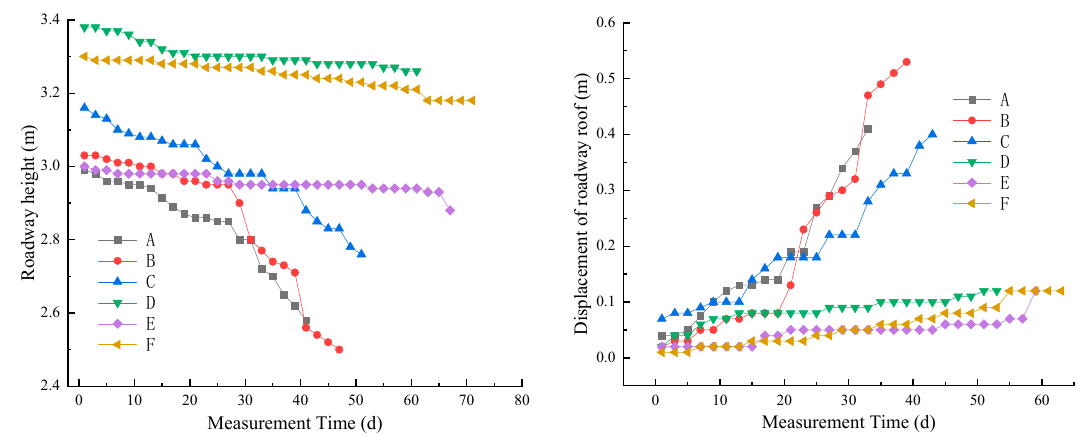
Figure 13. Distance variation curve of ZF3806 roof and floor of mining roadway.